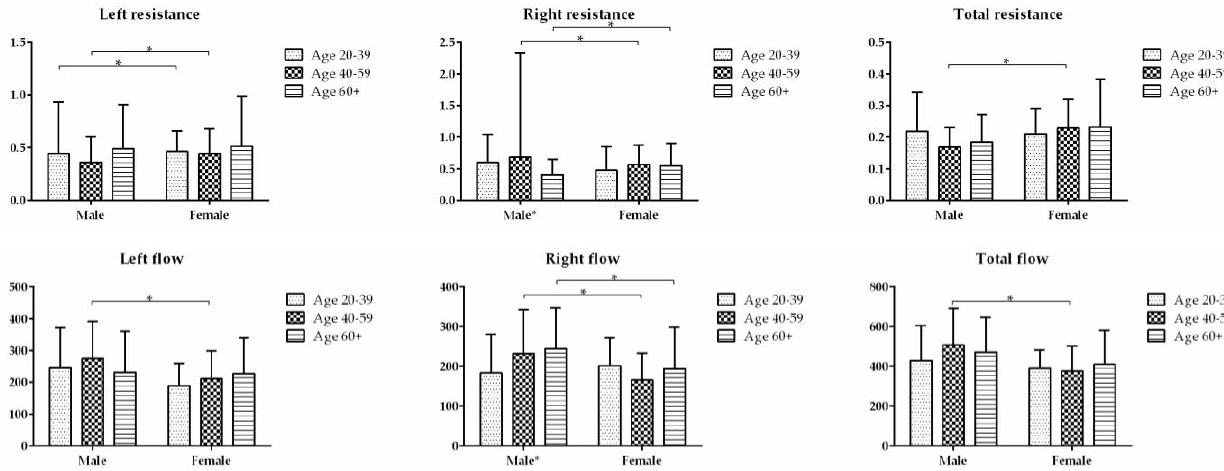
Figure 2. The nasal inspiratory resistance (Pa/cm 3 /s) and nasal flow (cm 3 /s) at a fixed pressure of 75 Pascal in 3 age groups were compared between the males and females. * indicates the difference is statistically significant ( p < 0.05). Table 2. Nasal flow (cm3/s) at a fixed pressure of 75